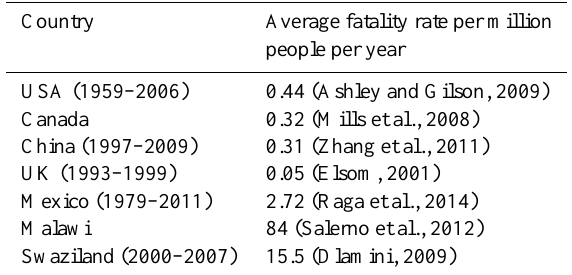
Figure 1. Relative contributions of lightning incident data sources to the total data set. TSMS is the Turkish State Meteorological Ser- vice, and ESWD is the European Severe Weather